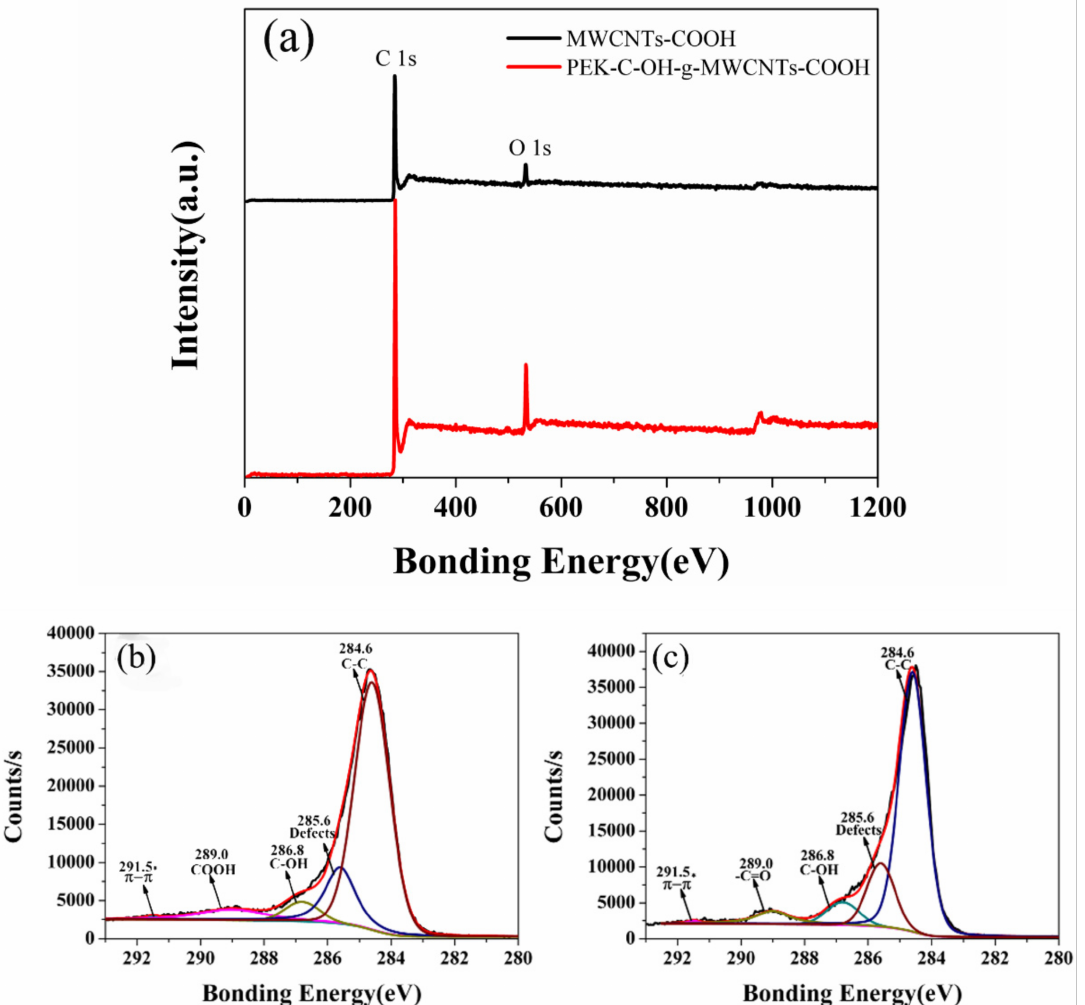
Figure 3. ( a ) XPS wide scan spectrum of MWCNTs-COOH and PEK-C-OH-g-MWCNTs-COOH; ( b ) XPS C1s fine scan spectra of MWCNTs-COOH; ( c ) XPS C1s fine scan spectra of PEK-C-OH